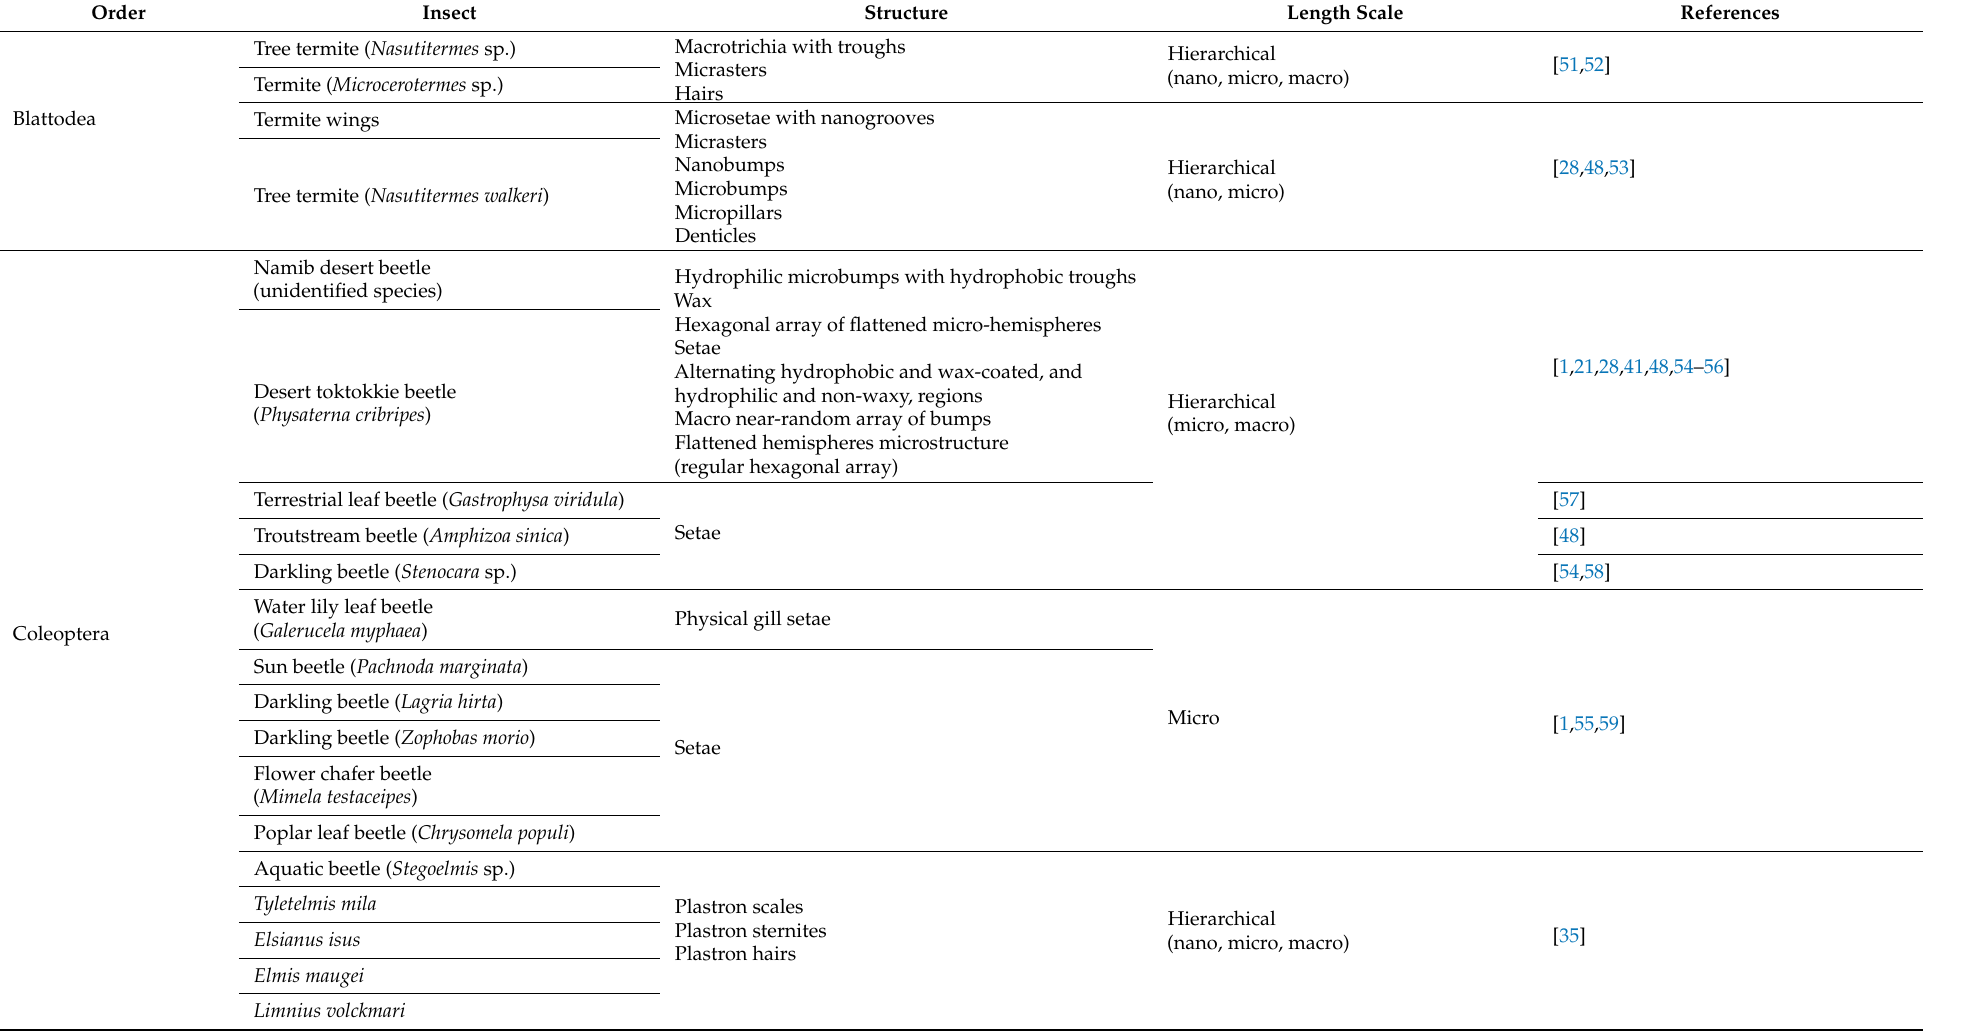
Table 2. Cuticular surface structures of